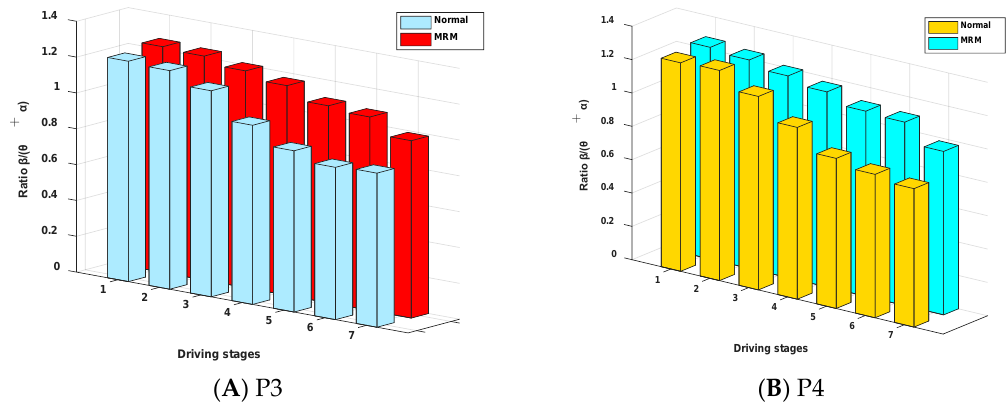
Figure 9. The ratio β/θ + α of the relative power spectrum.